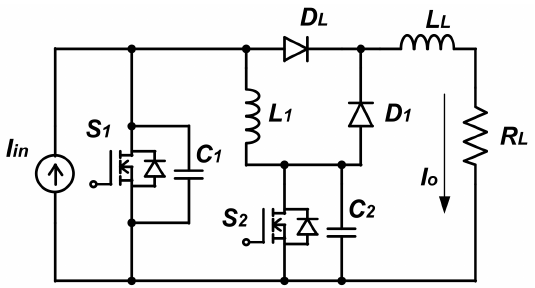
Figure 1. Non-inverting design of half-type resonant switched-inductor converter circuit.